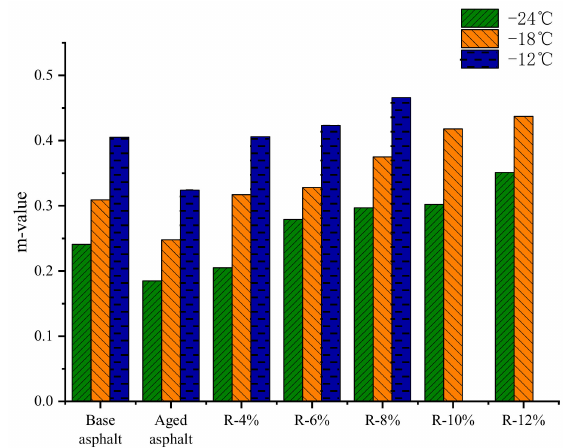
Figure 8. m of different reclaimed asphalt